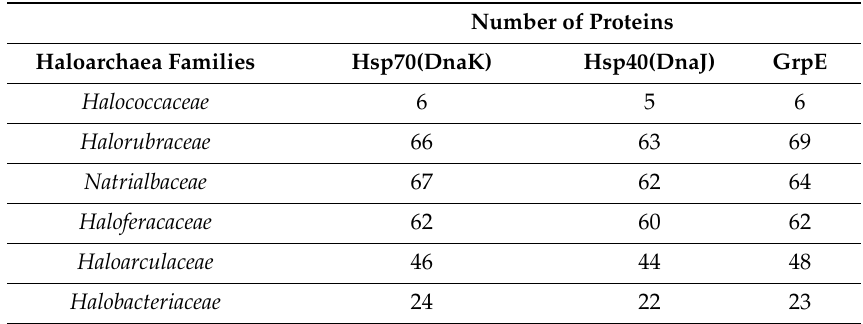
Table 3. Molecular machinery (Hsp70, Hsp 40 and GrpE proteins) found in some halophilic archaea